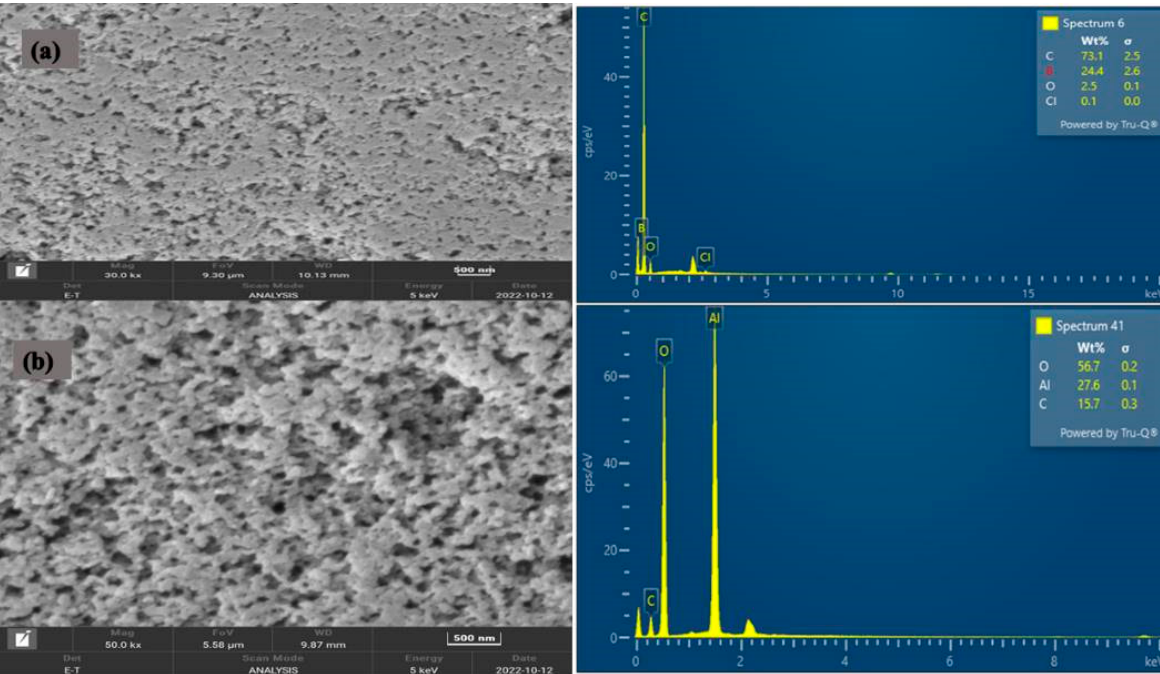
Figure 3. FESEM and EDX of ( a ) Before loading CRB05 ( b ) After loading CRB05.